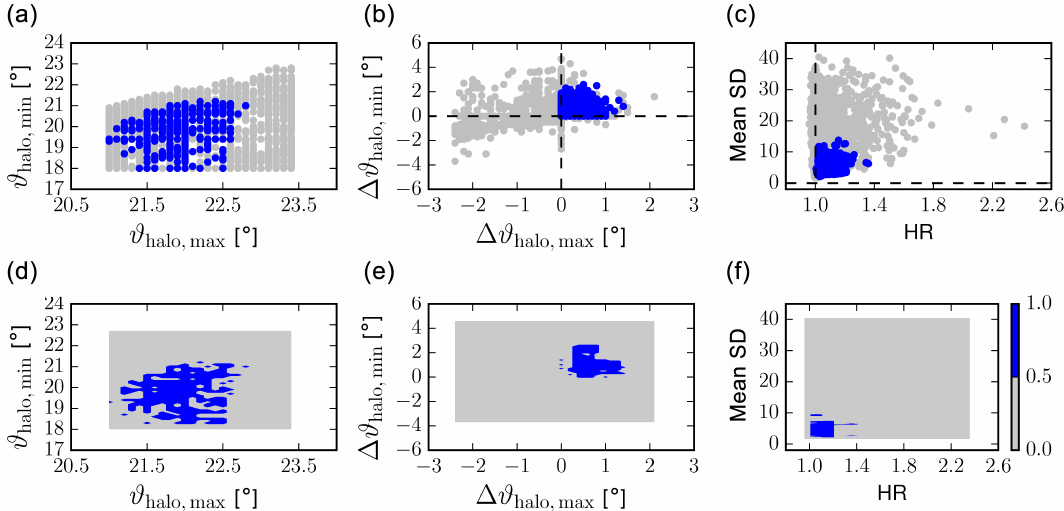
Figure 8. (a–c) Scatter plots of selected pairs of the eight features used for training HaloForest. Training samples with(out) 22 ◦ halos are represented in blue (gray). (d–f) Decision boundaries of the random forest classifier for the respective feature pair. The predicted probability used for separating the classes “22 ◦ halo” ( p > 0 . 5) and “no 22 ◦ halo” ( p ≤ 0 . 5) is displayed in blue and gray, respectively.